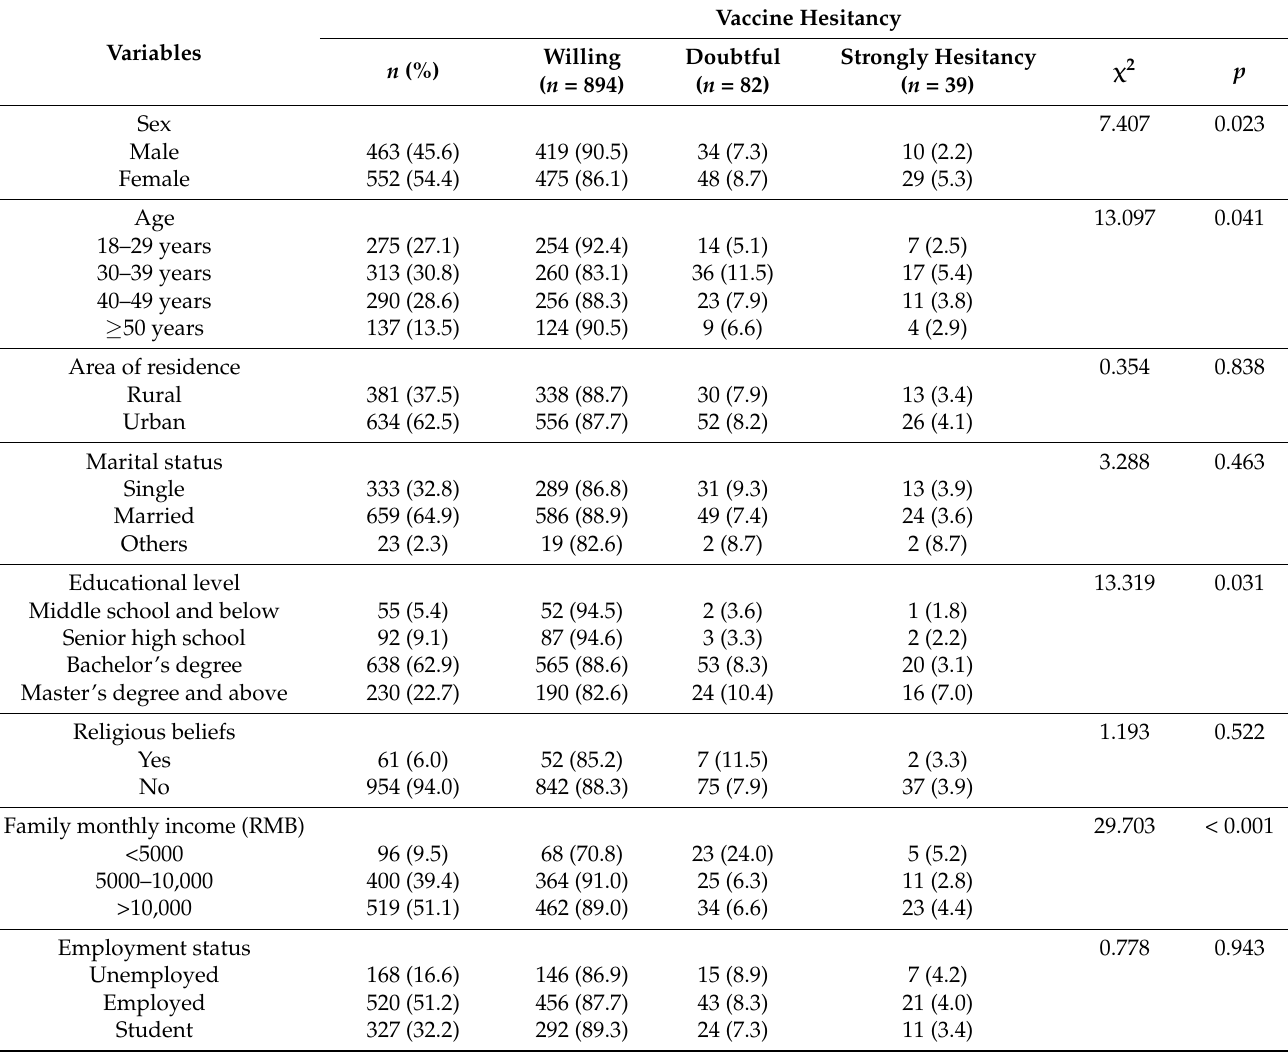
Table 1. Descriptive statistics of sociodemographic characteristics ( N =